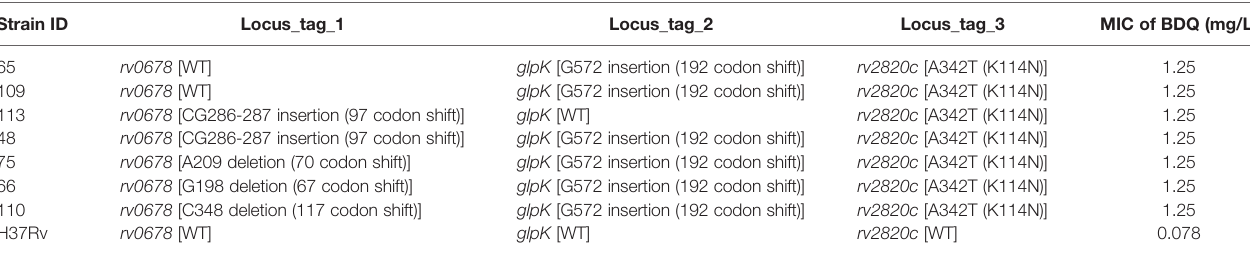
TABLE 4 | MIC of BDQ-resistant mutants of